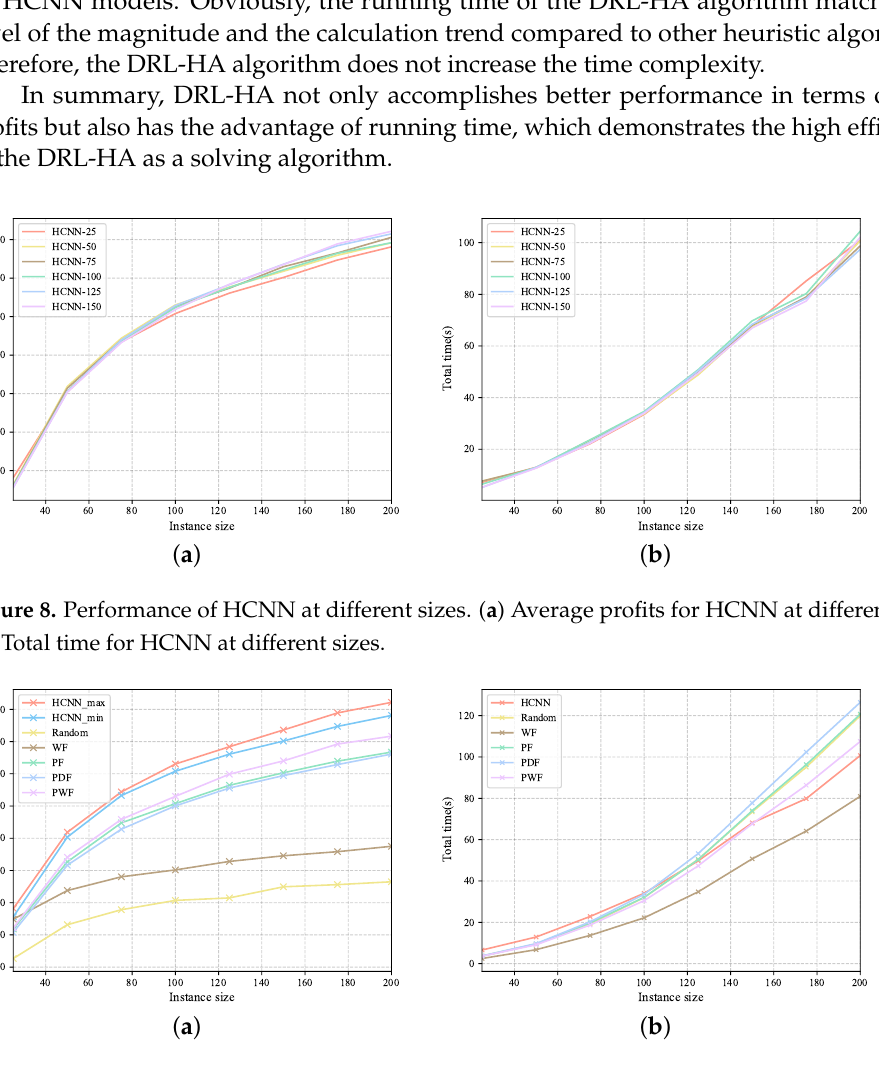
Figure 9. Performance of the algorithms for scenarios with different scales. ( a ) Average profits of the algorithms for scenarios with different scales. ( b ) Total time of the algorithms for scenarios with different